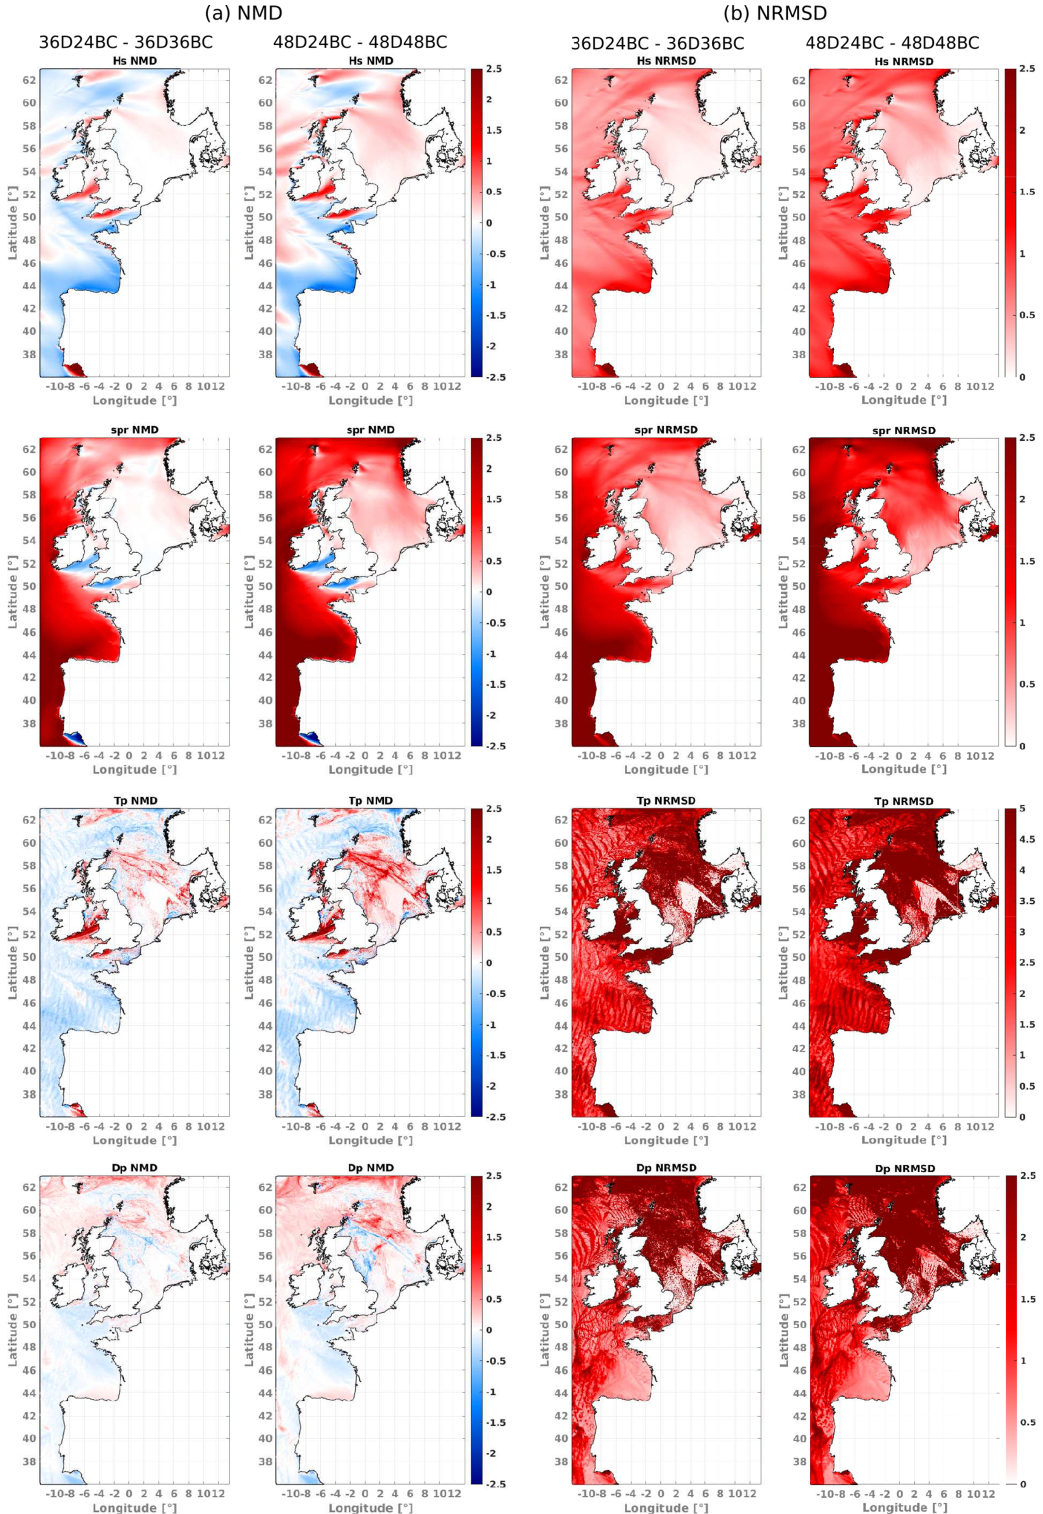
Figure 12. (a) Normalized mean differences (NMDs) and (b) normalized root mean squared differences (NRMSDs) between tests 36D24BC − 36D36BC and 48D24BC − 48D48BC. Analyzed period: February 2011. Color bars represent changes in quantities between tests in